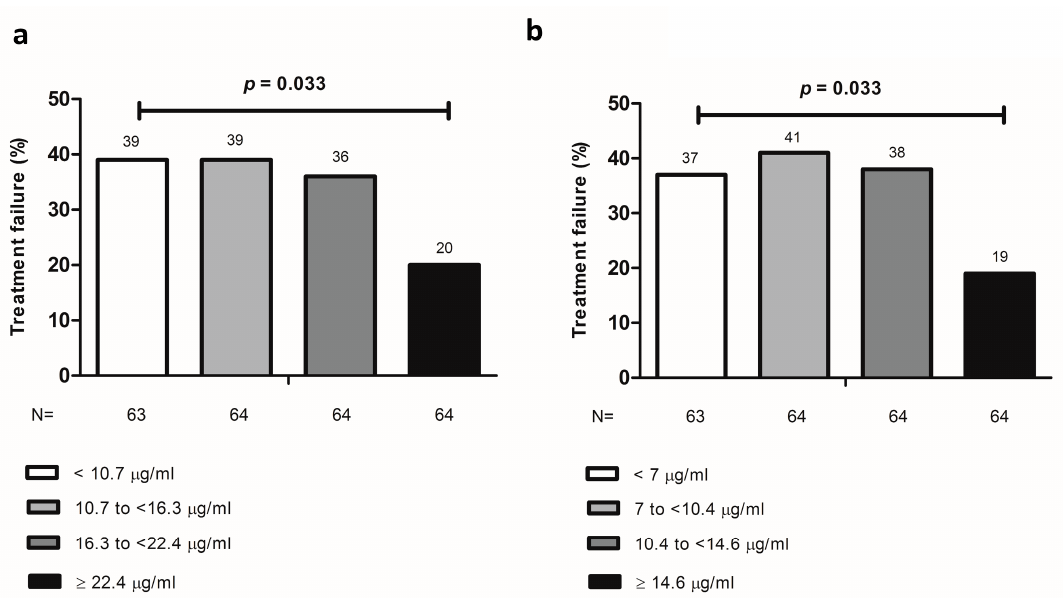
Figure 2. Treatment failure by quartiles of adalimumab concentration at last affected therapeutic drug monitoring before ( a ) or after ( b ) the implementation of the corrected measures.